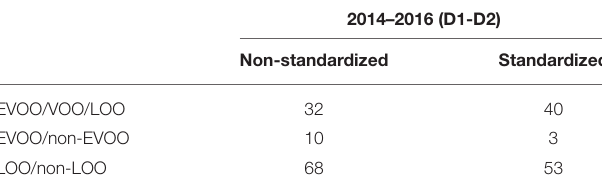
TABLE 1 | Number of neurons chosen for the hidden